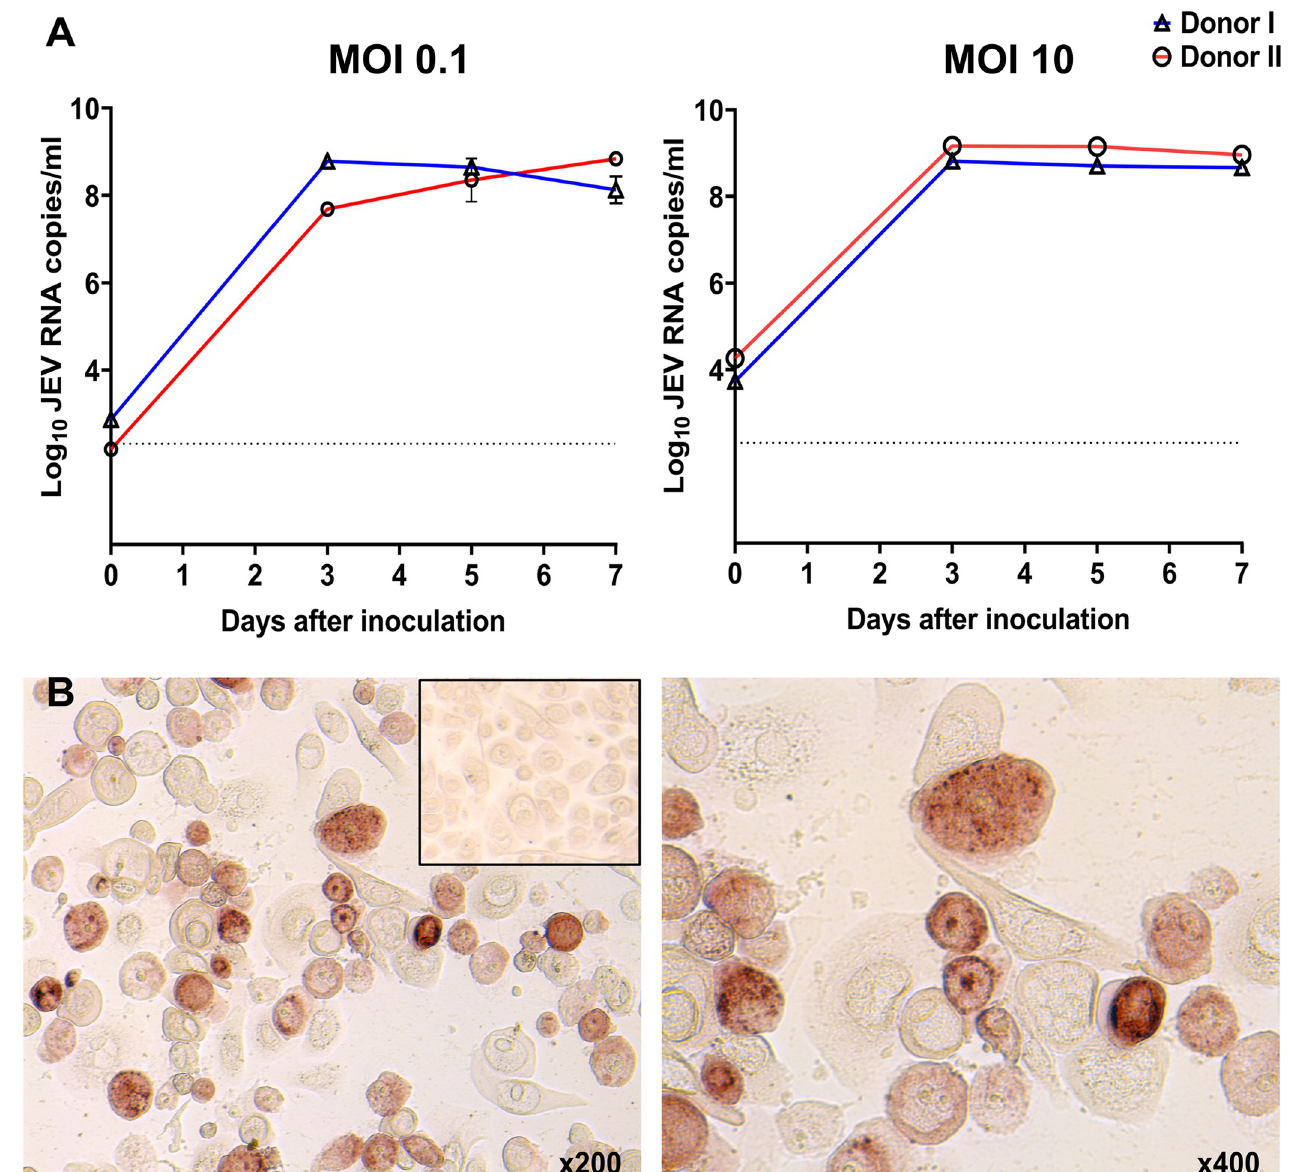
Fig 1. Japanese encephalitis virus causes persistent infection in human primary vaginal epithelial cells. ( A ) JEV infection kinetics in human primary vaginal epithelial cells. ( B ) Immunohistochemistry specific for the JEV envelope protein in human vaginal epithelial cells at 7 days after inoculation (MOI 10). The combination of virus-positive and virus-negative cells in close proximity was observed. The insert shows mock-inoculated cells.